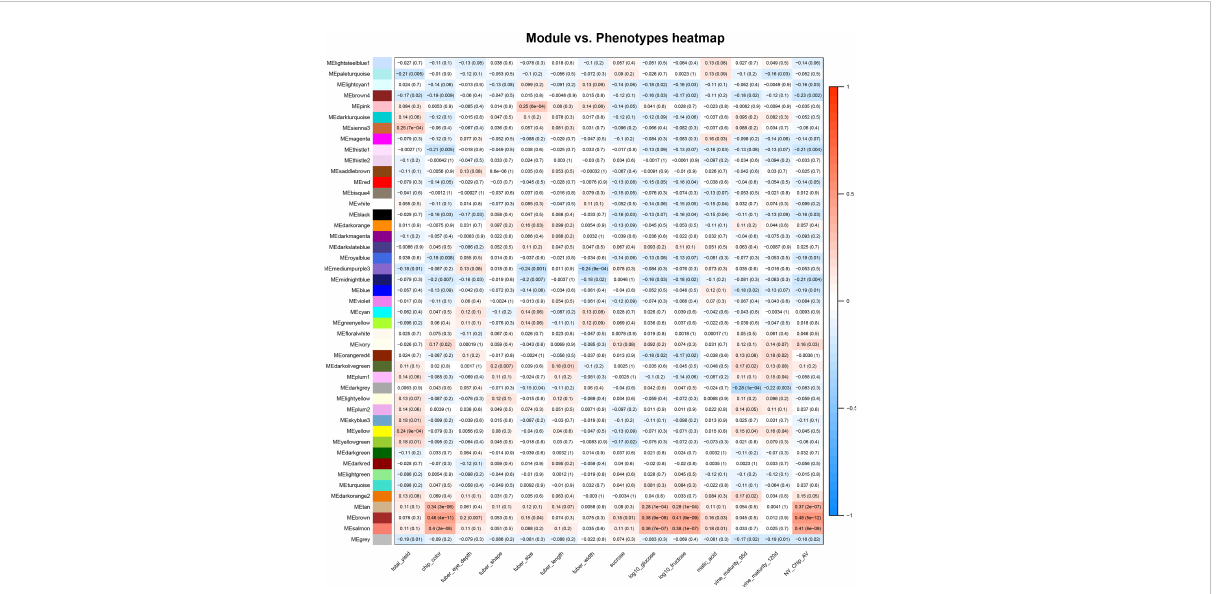
FIGURE 1 Correlations between the tuber metabolome and tuber and vine phenotypes. A heat map summarizes correlations between module eigenvalues (y- axis) and phenotypic traits (x-axis); red denotes a positive correlation and blue indicates a negative correlation between traits and module eigenvalues. The numbers in the boxes are correlation coef fi cients and, in parentheses, p values for the relationship. The phenotypic traits shown in this fi gure are total yield, potato chip color (measured on a 1-5 scale), tuber eye depth, shape, size, length, and width, as well as sucrose, log 10 glucose, log 10 fructose, malic acid, and vine maturity at 95 and 120 days. All trait scores were provided by SolCAP (Rosyara et al.,